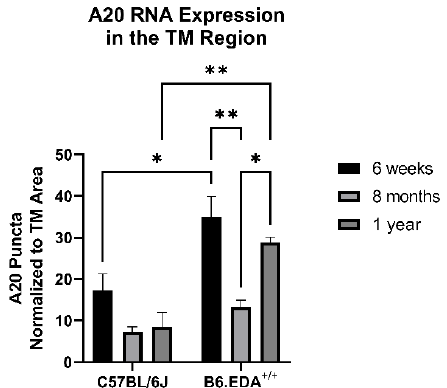
Figure 7. A20 RNA expression has a cyclic relationship with age in B6.EDA +/+ mice versus control C57BL/6J mice. Mouse eyes ( n = 3 for each timepoint and mouse strain) were harvested from age- matched control C57BL/6J mice and B6.EDA +/+ mice. In situ hybridization for A20 was performed, and RNA puncta were counted in the TM outflow region and normalized to the TM area. A20 ex- pression was higher in B6.EDA +/+ mice at 6 weeks and 1 year of age, but not at 8 months, suggesting a cyclic relationship between A20 and age in B6.EDA +/+ mice. Importantly, no change was seen in A20 RNA expression in the control C57BL/6J mice across any timepoints. Statistical significance was calculated by two-way ANOVA with Tukey post-hoc analysis, with p < 0.05 considered statistically significant. Error bars show SEM. * = p ≤ 0.05, ** = p ≤ 0.01.